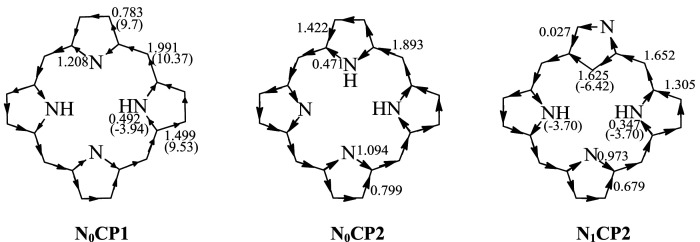
The RC values of compounds N0CP1, N0CP2 and N1CP2. All in units of that for benzene (I0). The chemical shift values of N0CP1 and N1CP2 are given in parentheses.